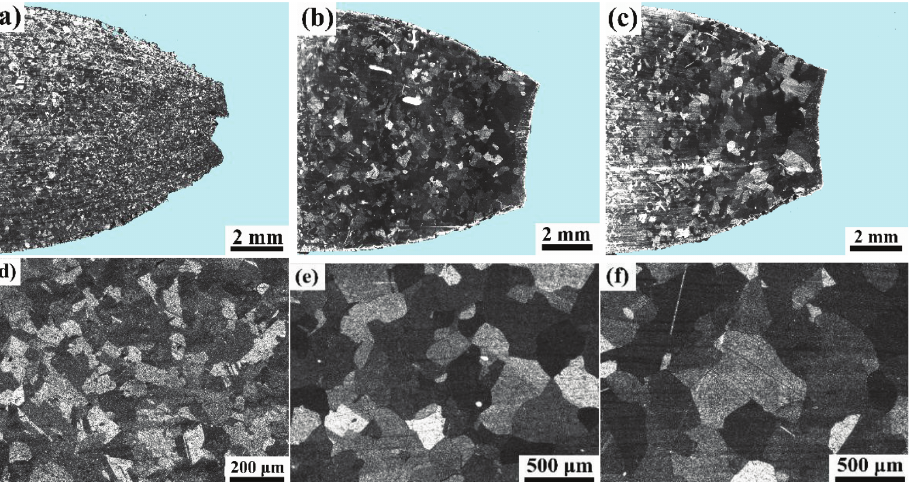
Figure 9: The macrostructure and microstructure of the longitudinal sections near the fracture front of alloy B1 specimens strained at different temperatures: (a, d) 1100°C; (b, e) 1150°C; (c, f)